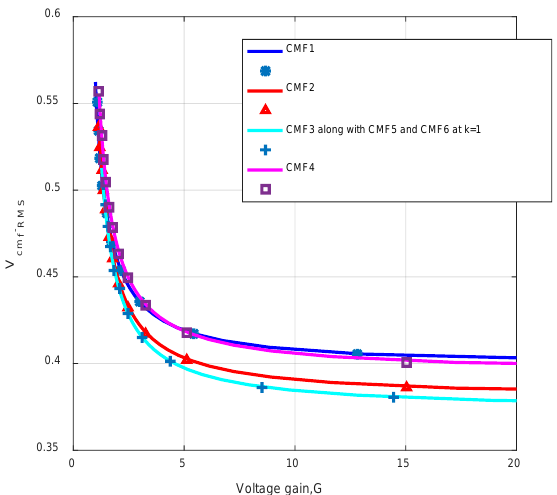
Figure 23. RMS-CMV per V dc Versus G. Solid lines: theoretical results, marks: simulation results.